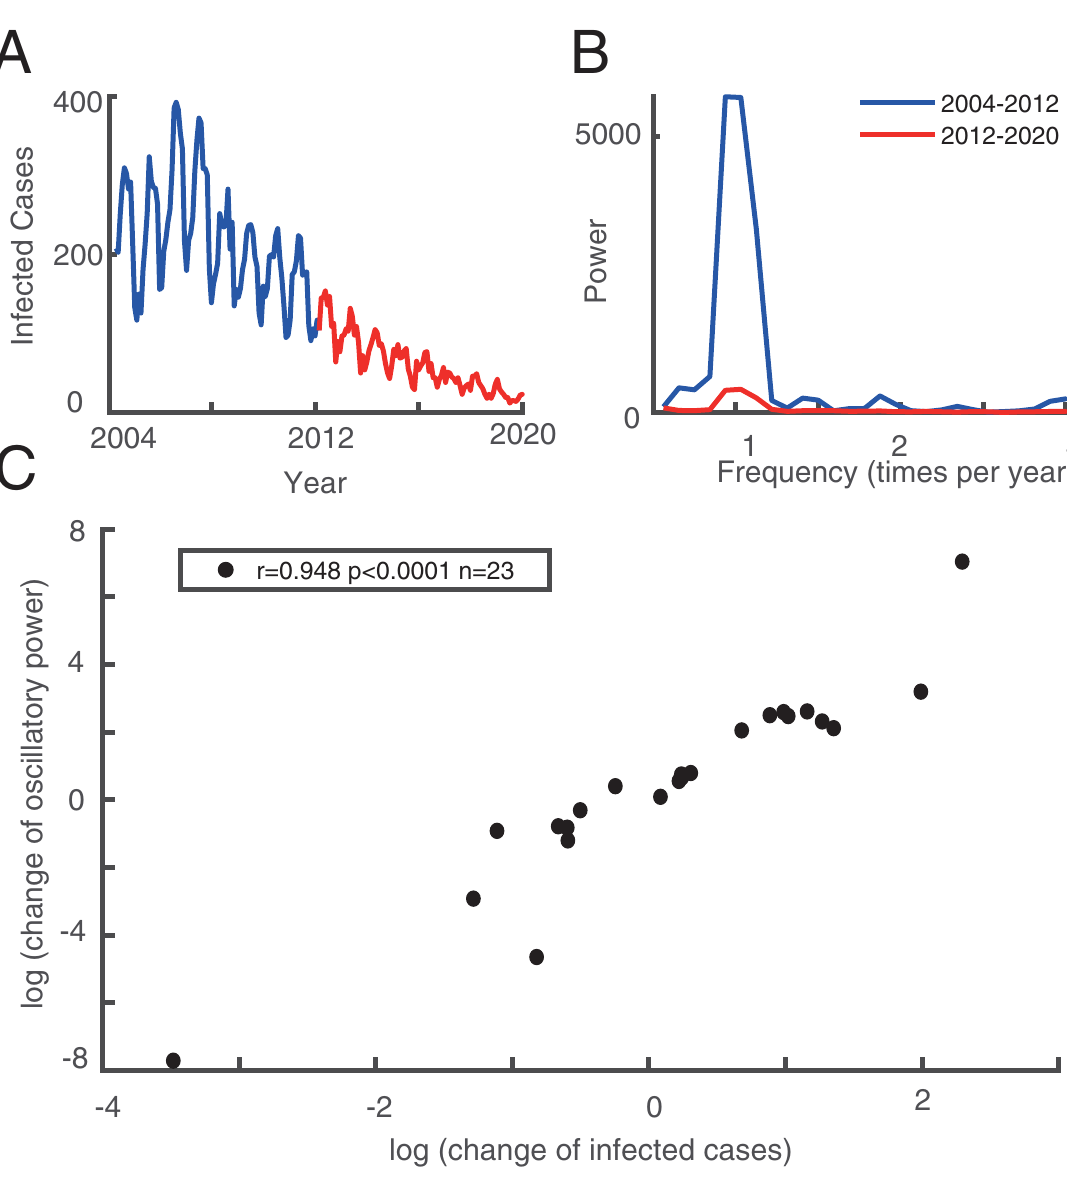
Fig 3. Relationship between the infection and its oscillatory strength. Plot A is an example of a disease’s time series monthly infected cases from 2004 to 2020. The blue curve shows the time series of the first eight years (2004–2012) and the red curve shows the time series of the last eight years (2012–2020). Plot B shows the power spectrum calculated in first eight years (blue curve) and the last eight years (red curve). Plot C shows the scatter plot of change in mean infected cases and change in oscillatory